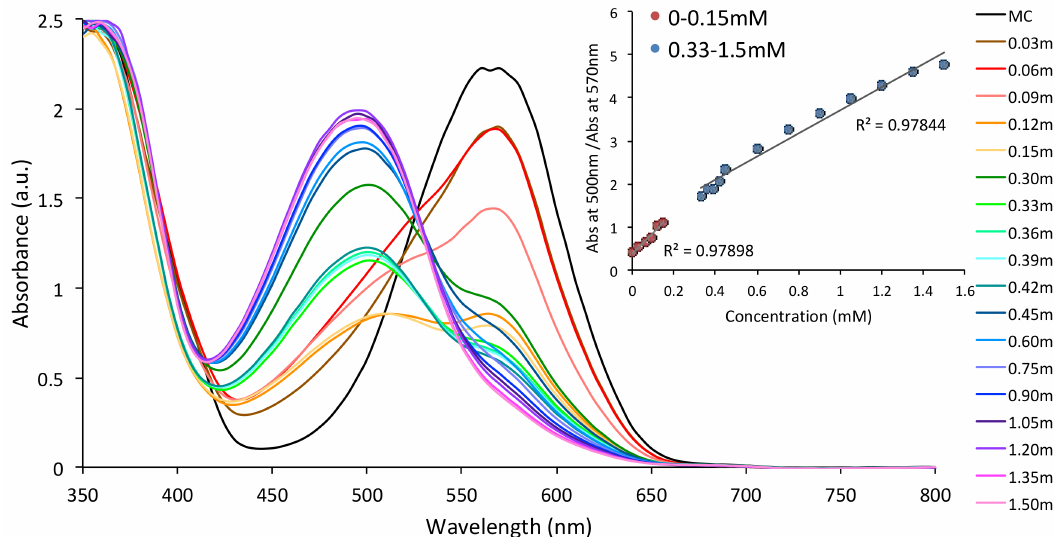
Figure 3. Absorbance changes of the SP solutions in ACN (1.5 × 10 − 3 M) in the presence of